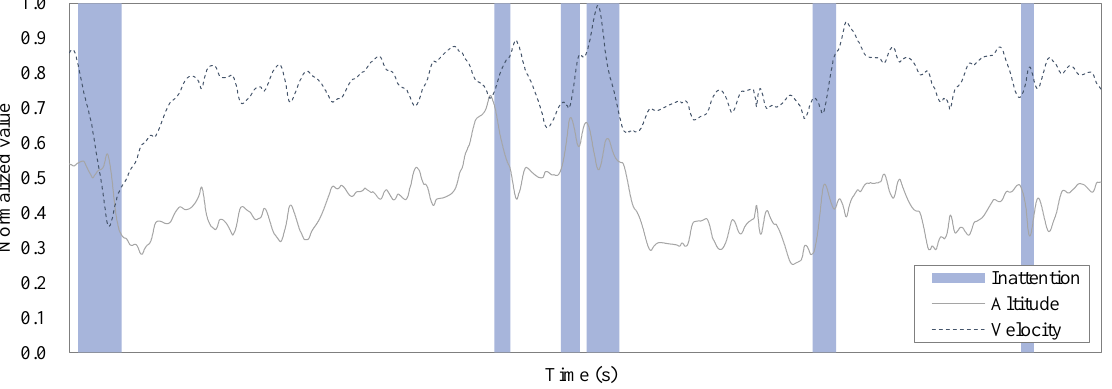
Figure 12. Example of labeled data according to the variances of altitude and velocity. Blue colored box indicates the inattention of an operator.